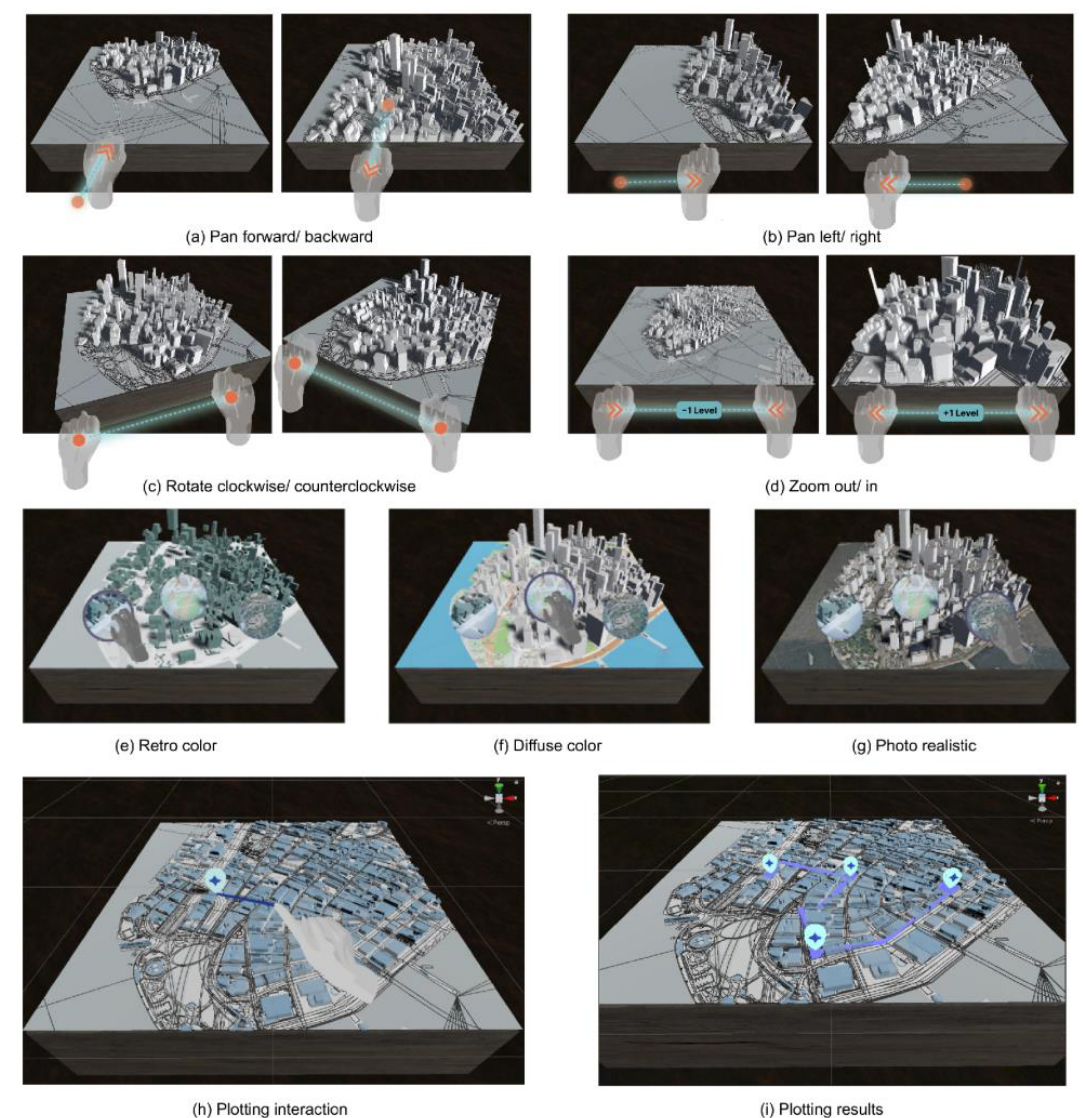
Figure 3. Function and Visualization of VR map navigation system.